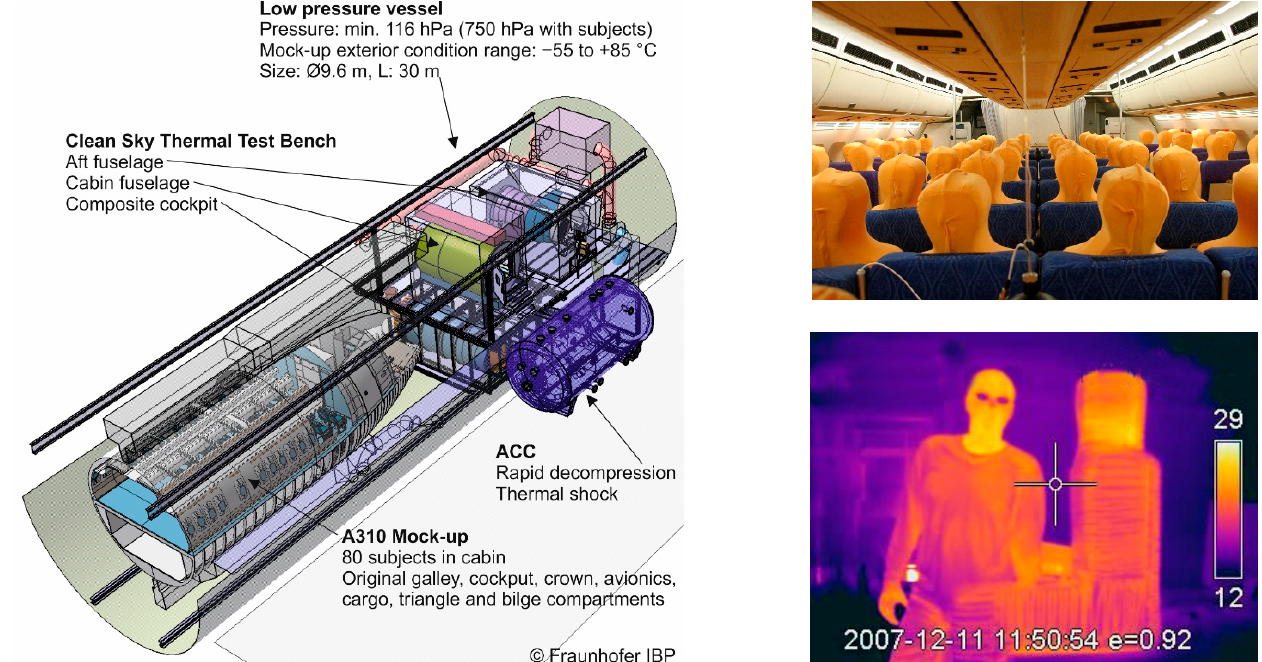
Figure 5. Overview of the Flight Test Facility, cabin equipped with thermal dummies, and IR picture of a human compared to a dummy.